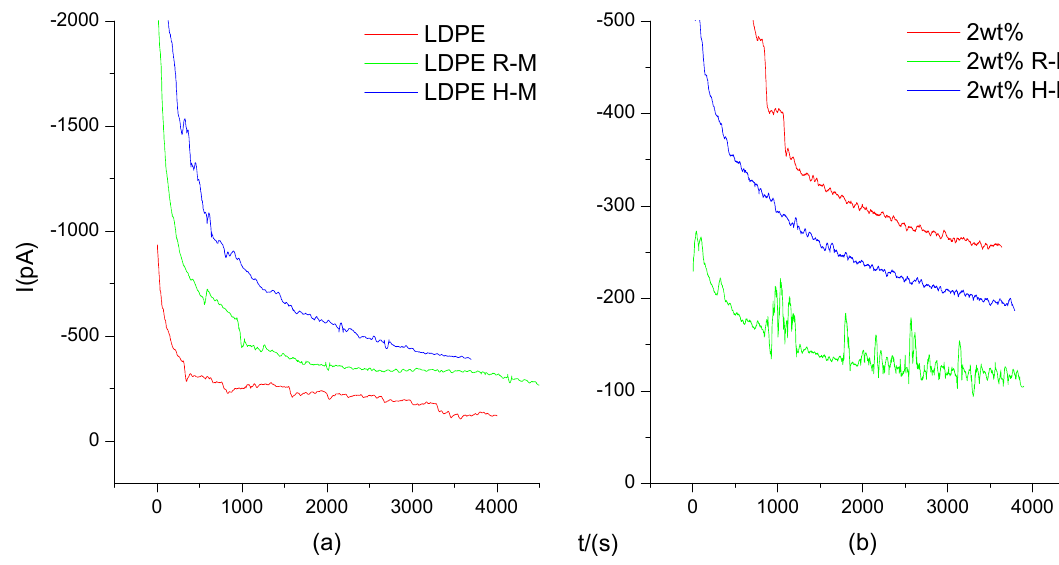
Figure 8. I-t characteristic curve of LDPE ( a ) and composites ( b ) under a 30 kV/mm electric field strength and different magnetization temperatures. ( a ) is the I-t characteristic curve of LDPE. ( b ) is the I-t characteristic curve of BiFeO 3 /LDPE composite. Curves LDPE and 2 wt% indicate no magnetization treatment. R-M is room temperature magnetization. H-M is high temperature magnetization.